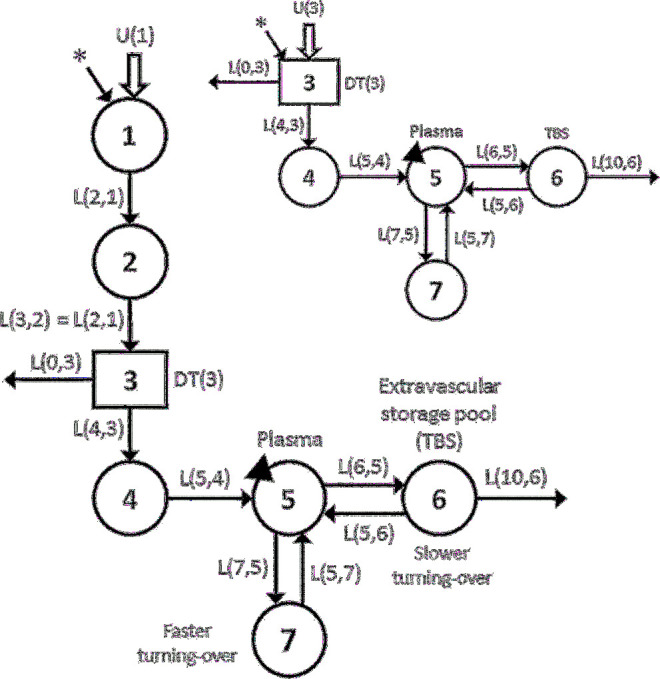
Working compartmental model for retinol kinetics in children. Circles represent compartments; the rectangle is a delay component and DT(3) is the delay time retinol spent in component 3; and interconnectivities between compartments (arrows) are fractional transfer coefficients [L(I,J)s, or the fraction of retinol in compartment J transferred to compartment I each day]. For example, L(6,5) is the fraction of retinol in compartment 5 transferred to compartment 6 each day and L(5,6) is the fraction in compartment 6 transferred to compartment 5 each day. Compartment 1 is the site of input of orally ingested tracer (*) and dietary vitamin A [U(1)]; fractional absorption efficiency was fixed at 0.80. Components 1–4 represent the processing of preformed dietary vitamin A, chylomicron production and metabolism, hepatic uptake of chylomicron remnant retinyl esters, and processing of retinol (compartment 4); delay component 3 is the site of loss of unabsorbed tracer. Retinol is secreted from the liver bound to retinol-binding protein into plasma compartment 5, the site of sampling (triangles). Retinol in the plasma pool can exchange with vitamin A in 2 extravascular compartments: a faster turning-over pool (compartment 7) and a slower turning-over storage pool (compartment 6), which is also the site of irreversible loss from the system. The inset shows the simplified model used to analyze the reduced data sets (protocols 2 and 3). In the simplified model, delay component 3 is the site of input for tracer (*) and dietary vitamin A [U(3)]. TBS, total body stores.